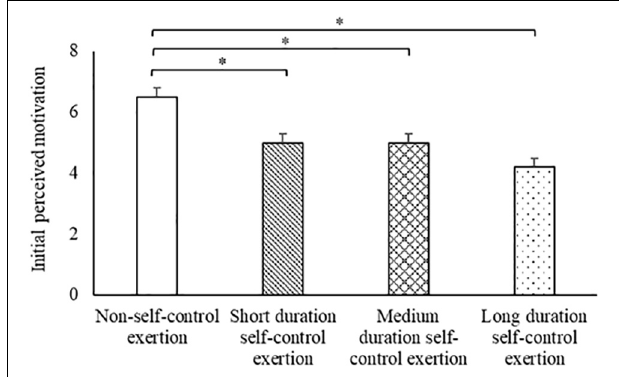
FIGURE 3 | Initial (30 s) perceptions of motivation across the trials. Data are mean ± SEM (main effect of trial, p < 0.001; * indicates difference between trials, p < 0.01).